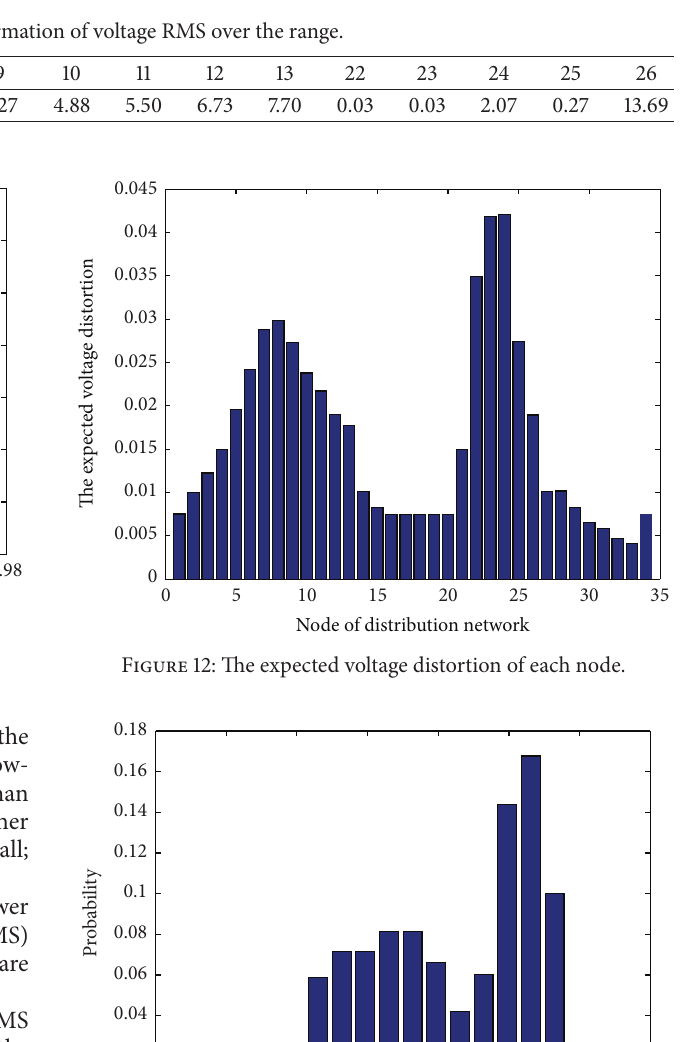
The probability distribution of THD V of Node 23 is shown in Figure